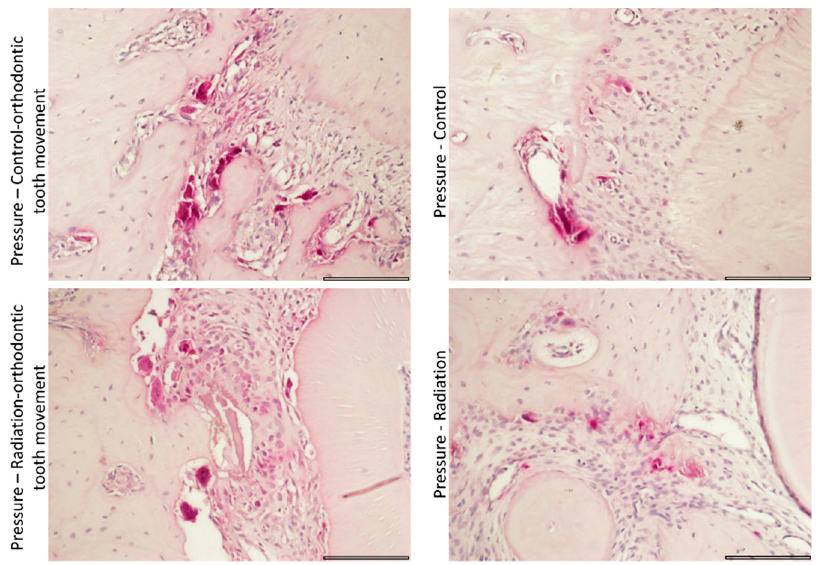
Figure 8. Representative sections of TRAP-stained sections for identification of active osteoclastic cells as a factor of study group in the pressure side (scalebar 50 μ ).